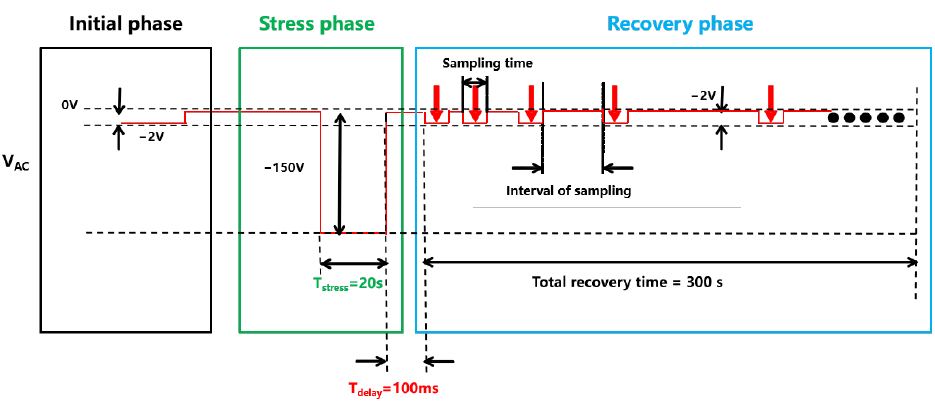
Figure 2. Dynamic measurement test sequence setting with STS8200.